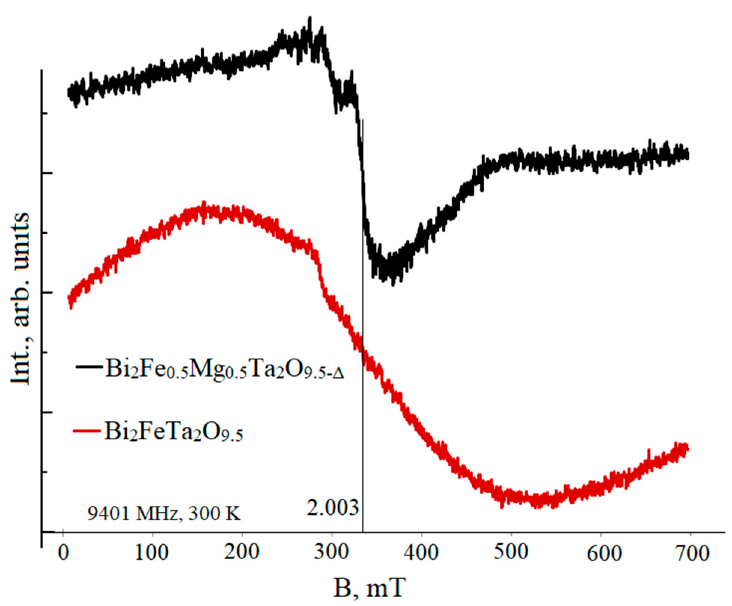
Figure 8. ESR spectra of the Bi 2 Fe 0.5 Mg 0.5 Ta 2 O 9.5- Δ and Bi 2 FeTa 2 O 9.5 . Reference sample line with g = 2.003.